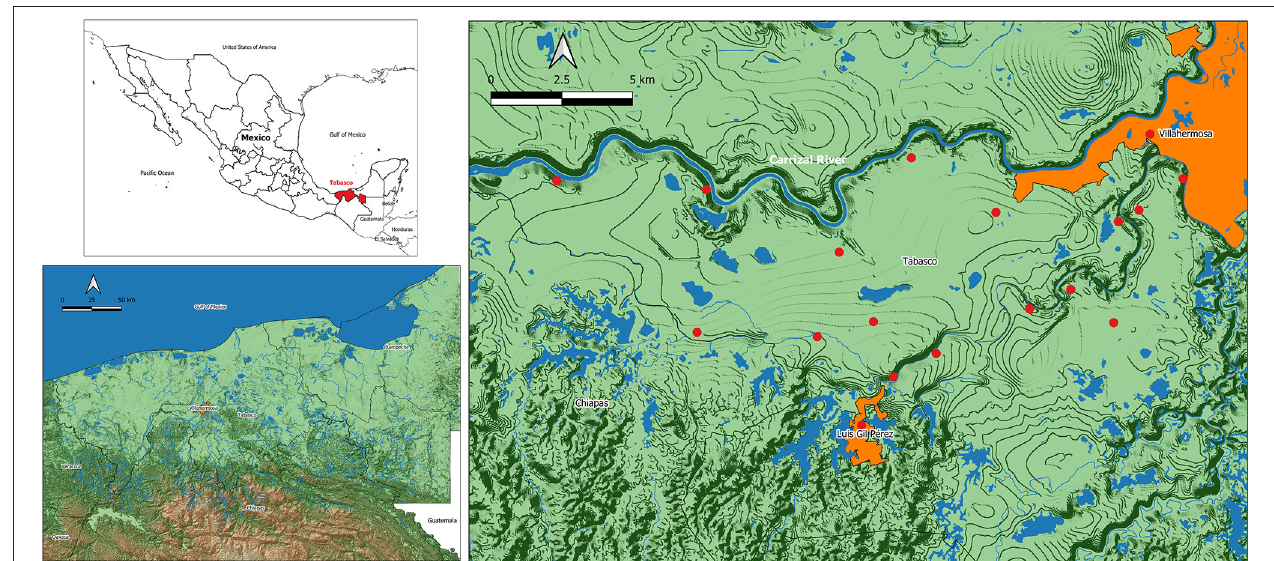
FIGURE 1 | Geographical location of the area of study. Tabasco, in southeast Mexico (top left), is a coastal plain with hot, humid climate and a large presence of wetlands and rivers (bottom left). Participant women received their prenatal medical care in one of the 17 rural first level public health centers (right, red dots) managed from Villa Luis Gil Pérez (orange area to the south), a town located a few kilometers southwest of the state’s capital city, Villahermosa (top right